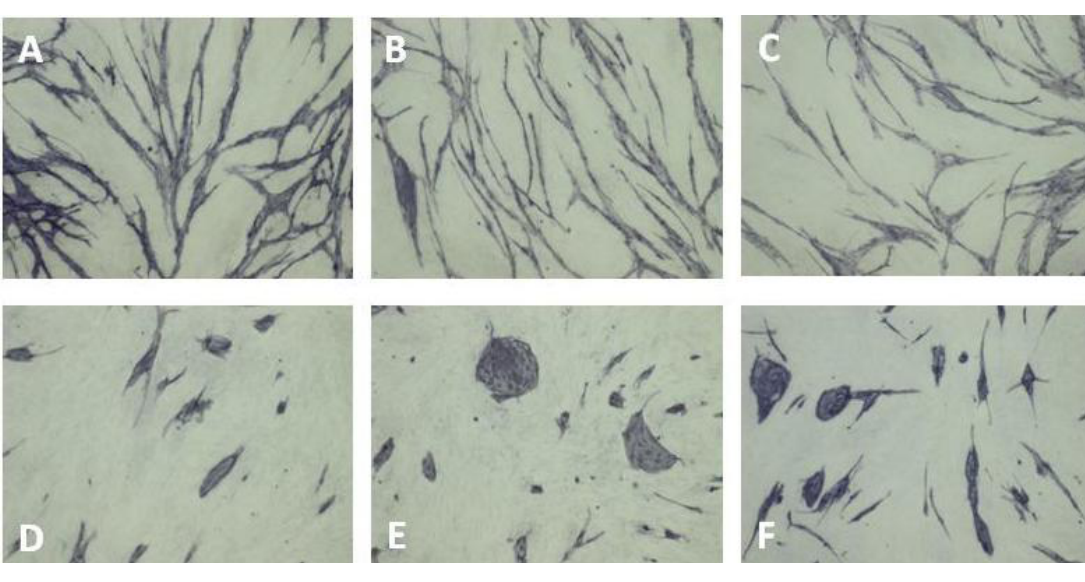
Figure 4. VEGF-dependent capillary-like tube formation of HMVECs propagated for three days in coculture with fibroblasts in ( A ) HMVEC5 medium, ( B ) HMVEC5 medium without bFGF, ( C ) HMVEC5 medium + 20 µg/mL goat anti-bFGF, ( D ) HMVEC5 medium without bFGF and VEGF, ( E ) HMVEC5 medium without VEGF, ( F ) HMVEC5 medium + 40 µg/mL goat